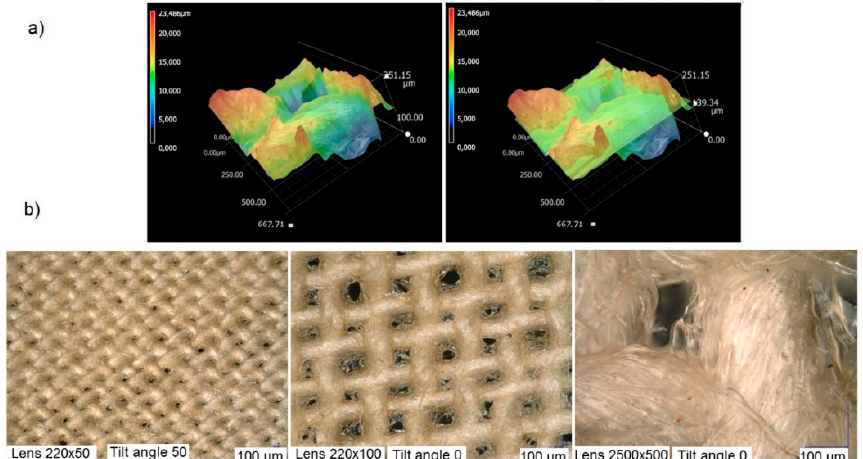
Figure 10. Three-dimensional 3D profile of Cellulose-starch composite ( a ); surface topographies at three magnifications (220 × 50; 220 × 100; 2500 × 500) ( b ). The images were made using a Keyence Microscope.